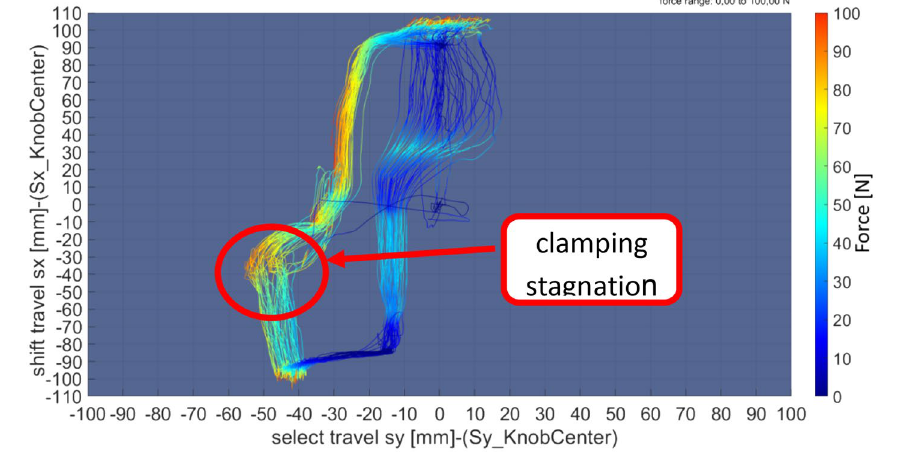
Figure 7. The actual diagram of cross shift